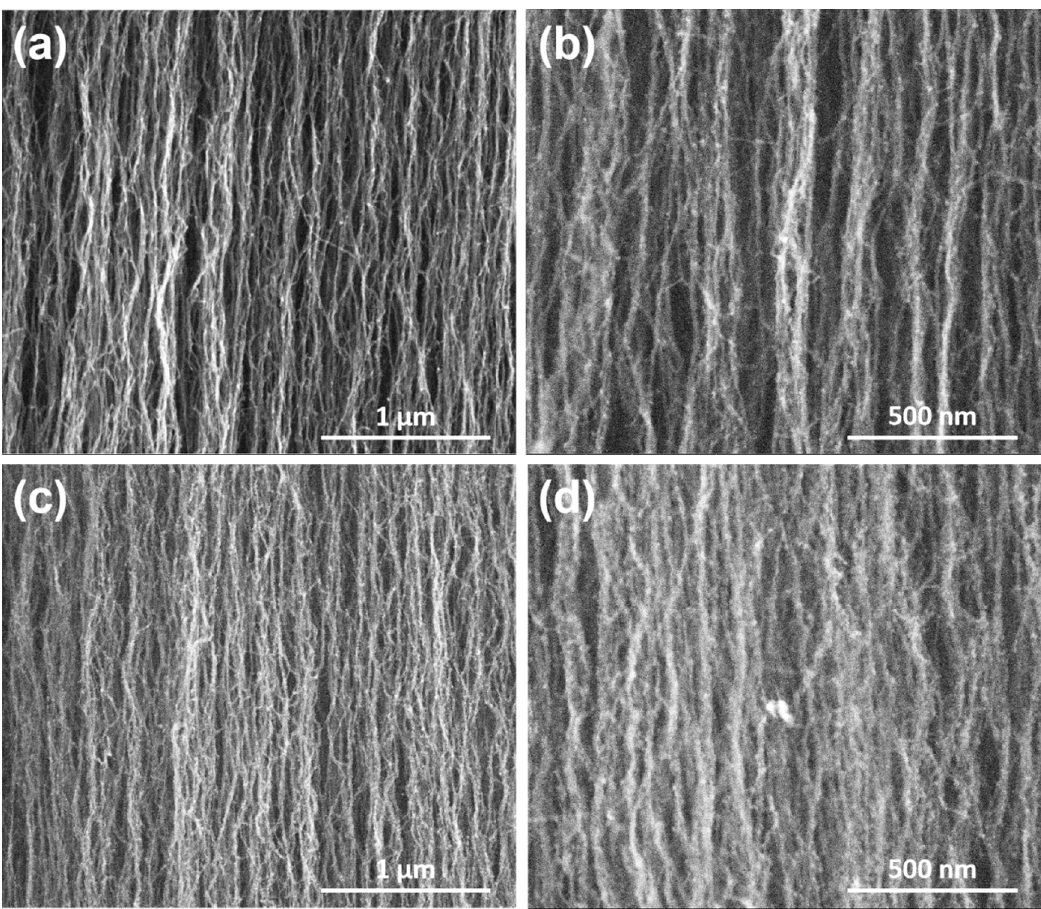
Figure S4b, the Raman spectra of the pristine VACNTs and Fe 3 O 4 /VACNTs composites